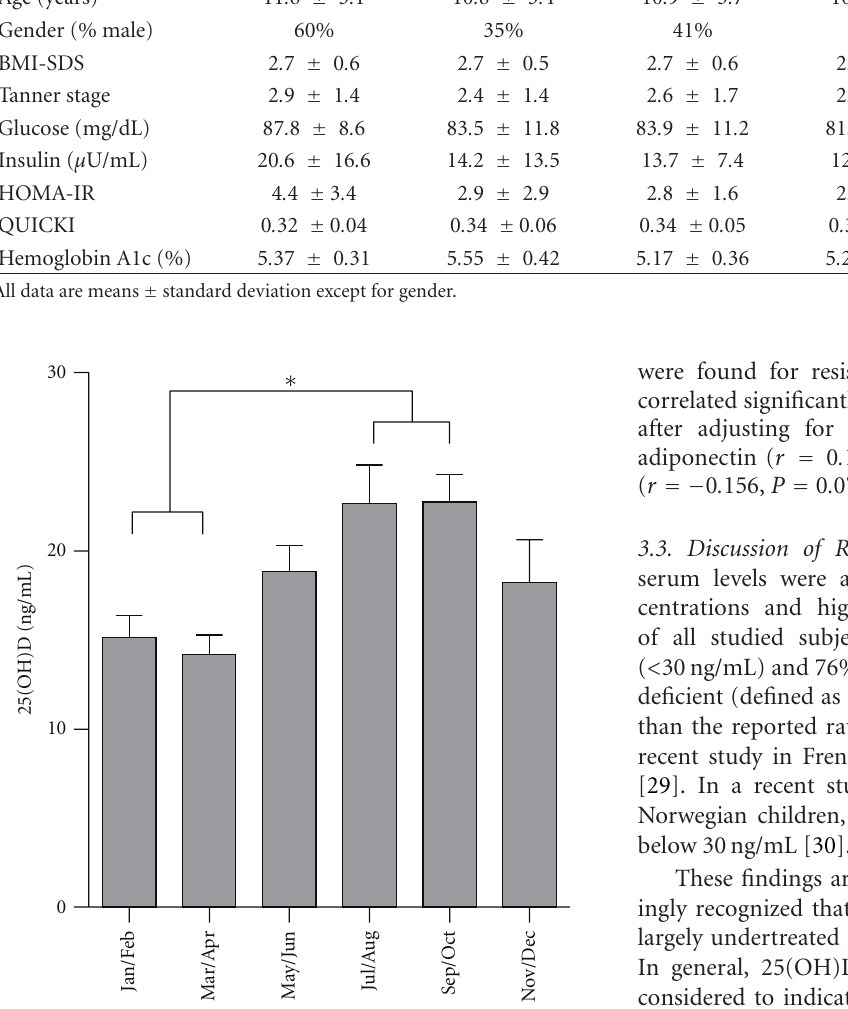
Figure 1: Seasonal changes of 25(OH) serum concentrations in all studied subjects showing significantly higher levels in summer and early fall (July–October), compared to winter and early spring (January–April, ∗ P < 0 .